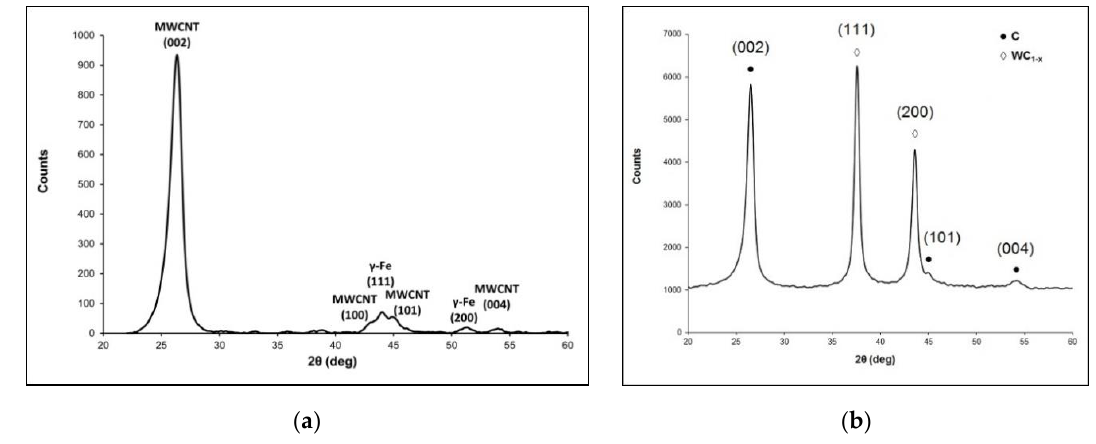
Figure2. TheX-raypowderdi ff ractionpatternsof( a )theinitialMWCNTsand( b )as-preparedcomposite material sample MWCNTs coated with pyrolytic tungsten carbide with initial MWCNTs / W(CO) 6 ratio of 1:3 (sample